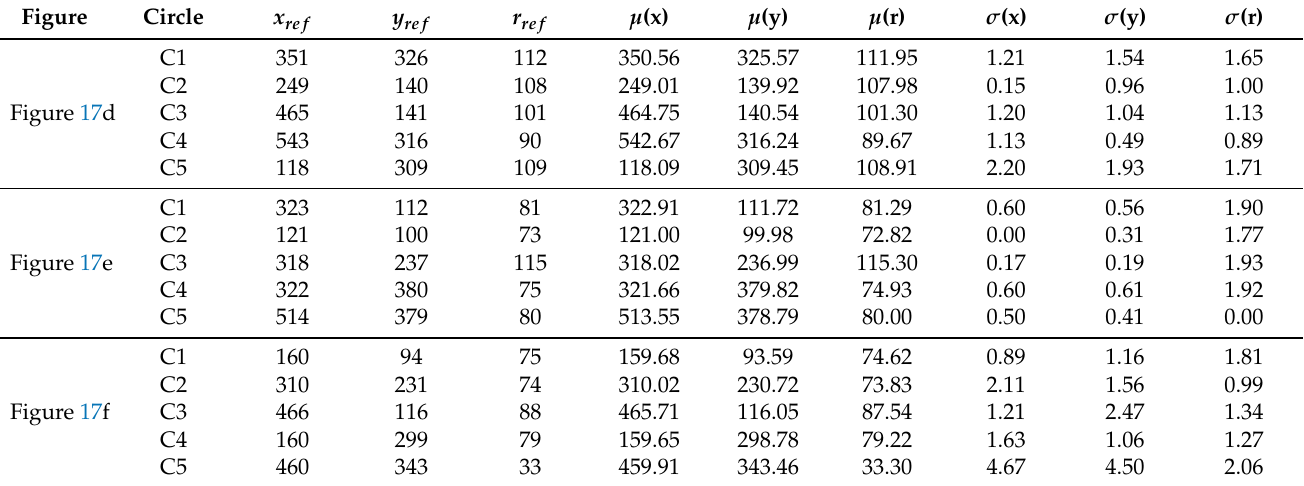
Figure 17. Sample images of each group under test containing 5 circles ( a – c ) and their corresponding output images with the detected circles superimposed ( d – f ). Table 7. Reference parameters detected by the reference system for images in Figure 17 (columns 2–5), their corresponding average of detected parameters (columns 5–7), and standard deviation (columns